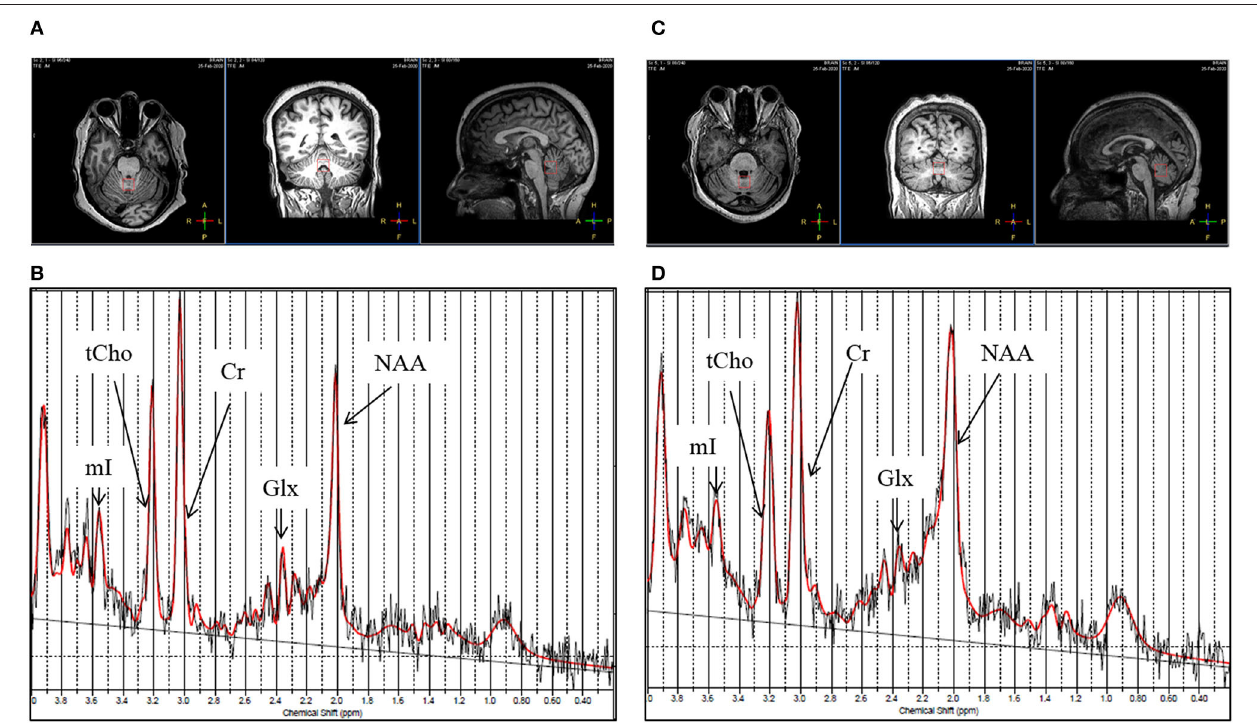
FIGURE 3 | (A) T1-weighted images of a healthy control (female, 44 years old) in axial, coronal, and sagittal plane. (B) Representative LC Model fitted 1 H-magnetic resonance spectroscopy spectrum obtained from the vermis of the same healthy control from the voxel highlighted in (A) . (C) T1-weighted image of a patient with gluten ataxia (female, 50 years old) in axial, coronal and sagittal plane. (D) Representative LC Model fitted 1 H-magnetic resonance spectroscopy spectrum acquired from the vermis of the same patient with gluten ataxia from the voxel highlighted in (C)